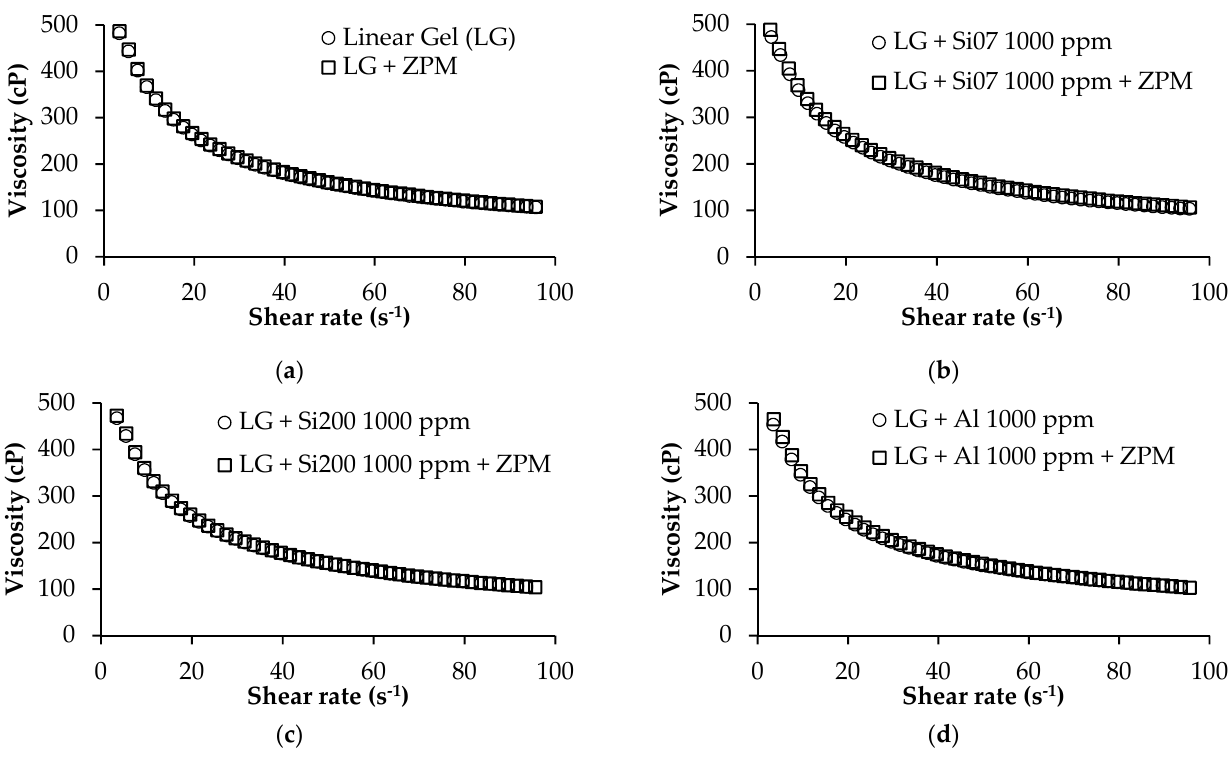
Figure 7. Viscosity as a function of shear rate at 25 °C for LG with and without ( a ) ZPM at its dosage in the FF formulation in the absence and presence of ( b ) Si07, ( c ) Si200 and ( d ) Al nanoparticles at 1000 mg/L.